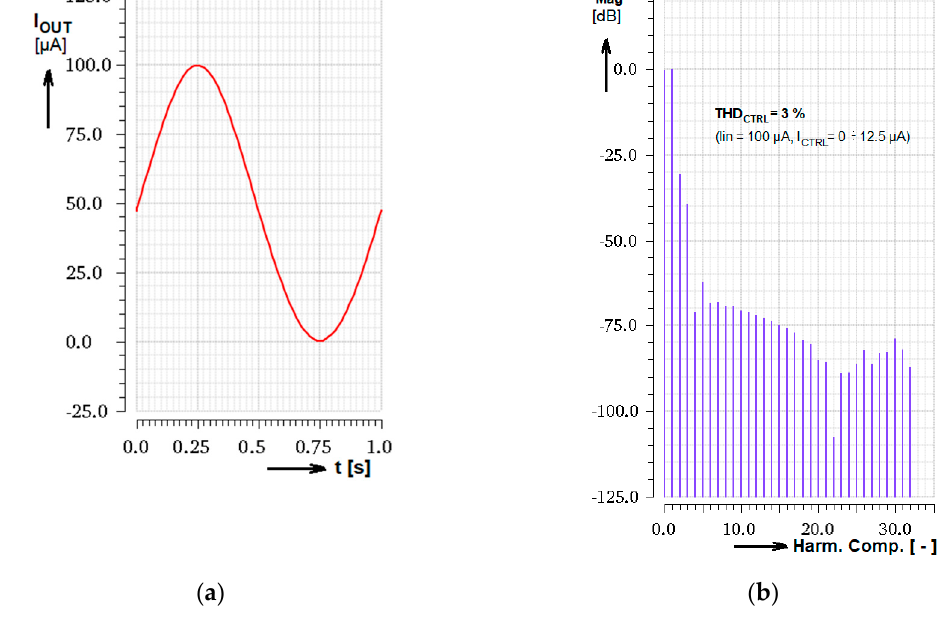
Figure 12. Simulated DFT analysis of the signal transferred from the gain control input; ( a ) Output current transient for I IN = 100 µA and the gain harmonically modified from 0 to 1; ( b ) DFT analysis expressed in dB related to the first harmonic component.